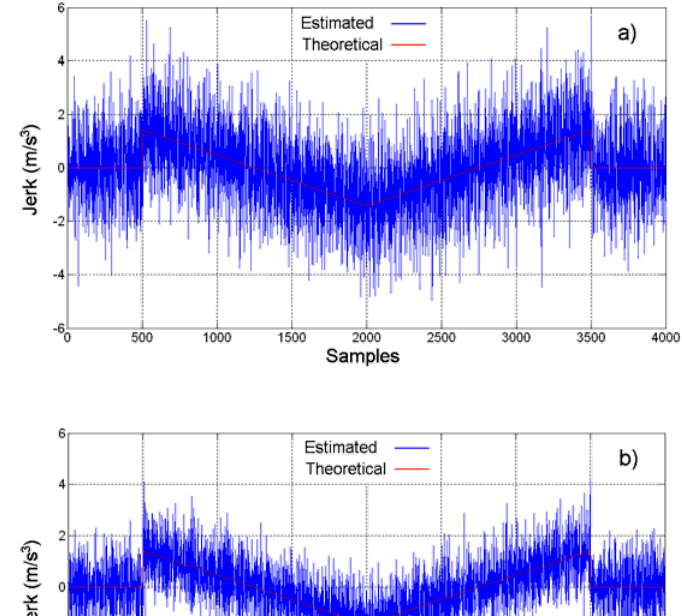
Figure 14. Jerk estimation with oversampling and direct decimation. (a) 4-times. (b) 8-times. (c) 16-times. (d)